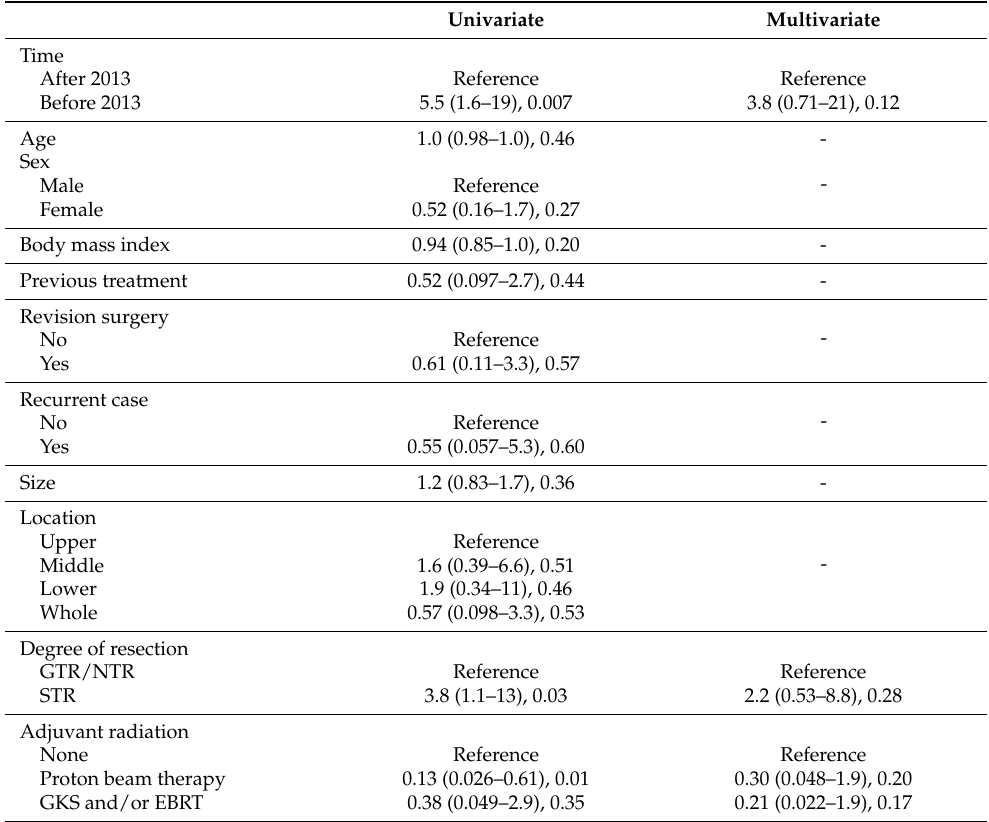
Table 4. The result of binary logistic regression analysis on a recurrence.